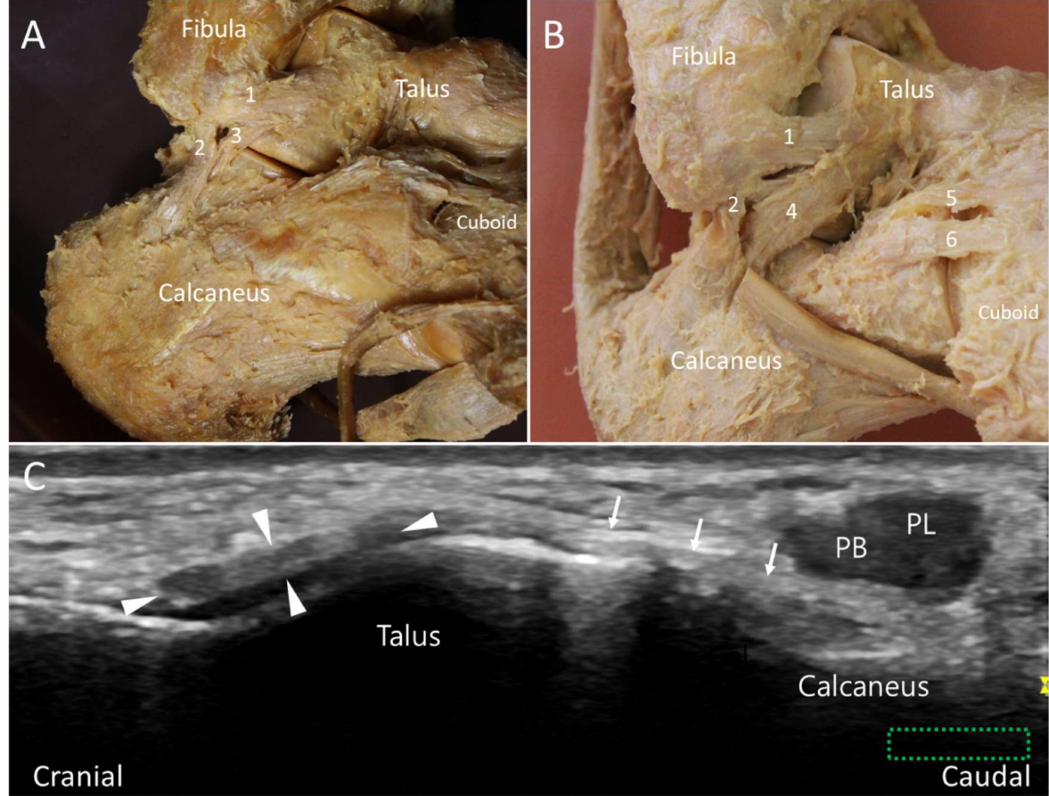
Figure 6. Type I ( A ) and type II ( B ) lateral talocalcaneal ligament in the cadaveric models. Ultrasound imaging shows the ligament (arrows) in its long axis ( C ). The colored dashed rectangle is in accordance with the transducer positions in Figure 2A. 1: Anterior talofibular ligament (arrowheads); 2: calcaneofibular ligament; 3: type I lateral talocalcaneal ligament; 4: type II lateral talocalcaneal ligament; 5: calcaneonavicular component of the bifurcate ligament; 6: calcaneocuboid component of the bifurcate ligament. PB: peroneus brevis tendon; PL: peroneus longus